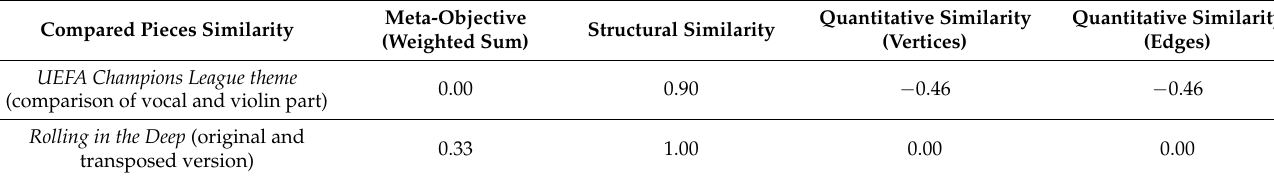
Table 8. Comparison of tracks in different